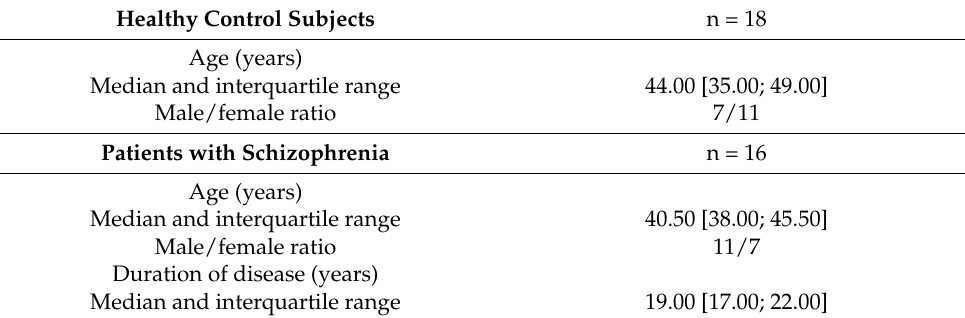
Table 1. Patients’ and healthy control subjects’